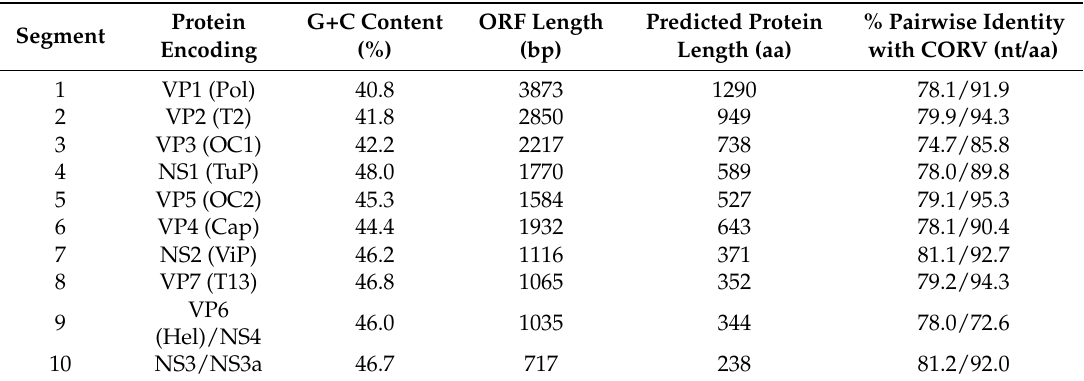
Table 2. PLV Genome Organisation.